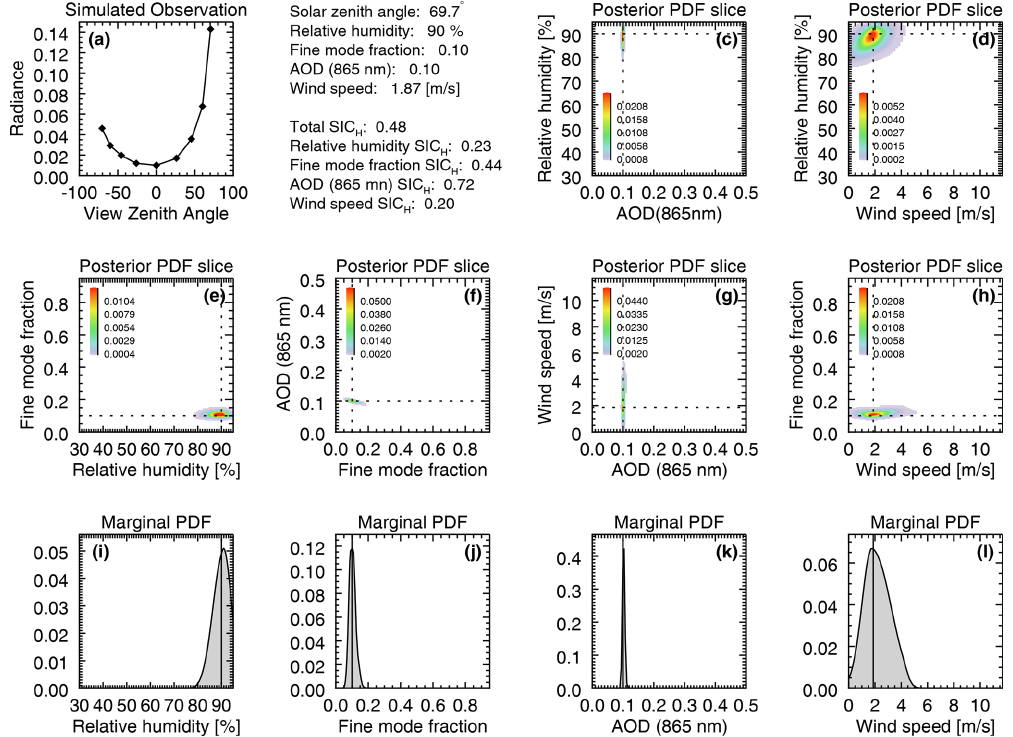
Figure 5. GENRA results for a retrieval with the same parameters as in Fig. 3, but for test case D. Now the solar zenith angle is θ s = 69 . 7 ◦ , so the sun glint is not observed (or at least is not obvious from the simulated observations in panel a ). Parameters remain the same, with r = 90%, f = 0 . 10, τ = 0 . 10, and w = 1 . 87ms − 1 , while overall SIC H decreases slightly to 0 . 48. As expected, SIC H for w decreases significantly, while it increases for all the other (aerosol)